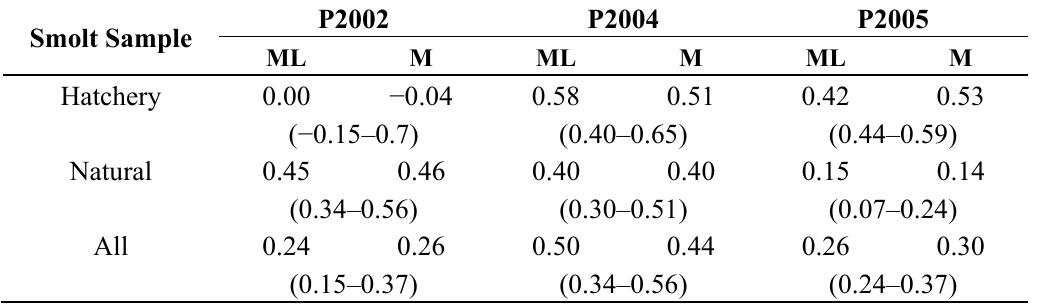
Table 8. Maximum likelihood (ML) and moment (M) estimates of contributions of three smolts produced in 2013 by adults that spawned in captivity (hatchery smolts) or in Sakinaw Lake (natural smolts). The 95% confidence intervals (CI) for the moment values shown in brackets were derived from bootstrapping over the 14 microsatellite